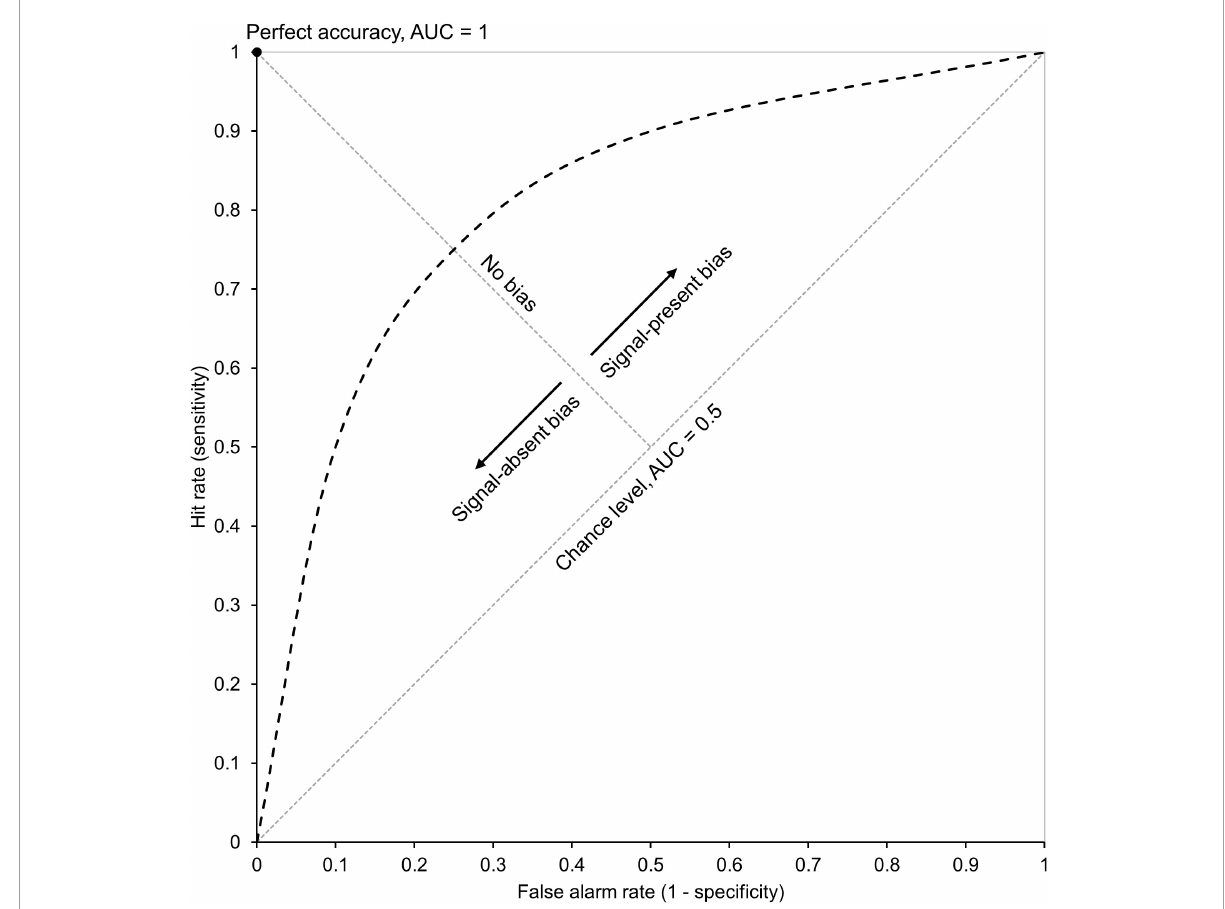
FIGURE1 Explanation of a ROC-curve. In selection, each applicant’s score on a selection instrument is compared to each possible cut-off score (criterion in SDT terms) for that instrument. Each application of a criterion yields a false alarm rate and a hit rate for the sample of students, a data point in the Receiver Operating Characteristics curve (ROC curve). A ROC curve visualizes the accuracy of a predictor in predicting an outcome by showing the data points in the decision space between chance level and perfect accuracy. Since the specificity equals 1- (the proportion of) false alarms, the proportion false alarms equals 1 - specificity. Specificity indicates predictor performance in case of absence of the signal, sensitivity indicates predictor performance in case of presence of the signal. Scenario-points A, B, and C correspond to the intended admission bias, rejection bias and bias free selection outcomes in Table 2